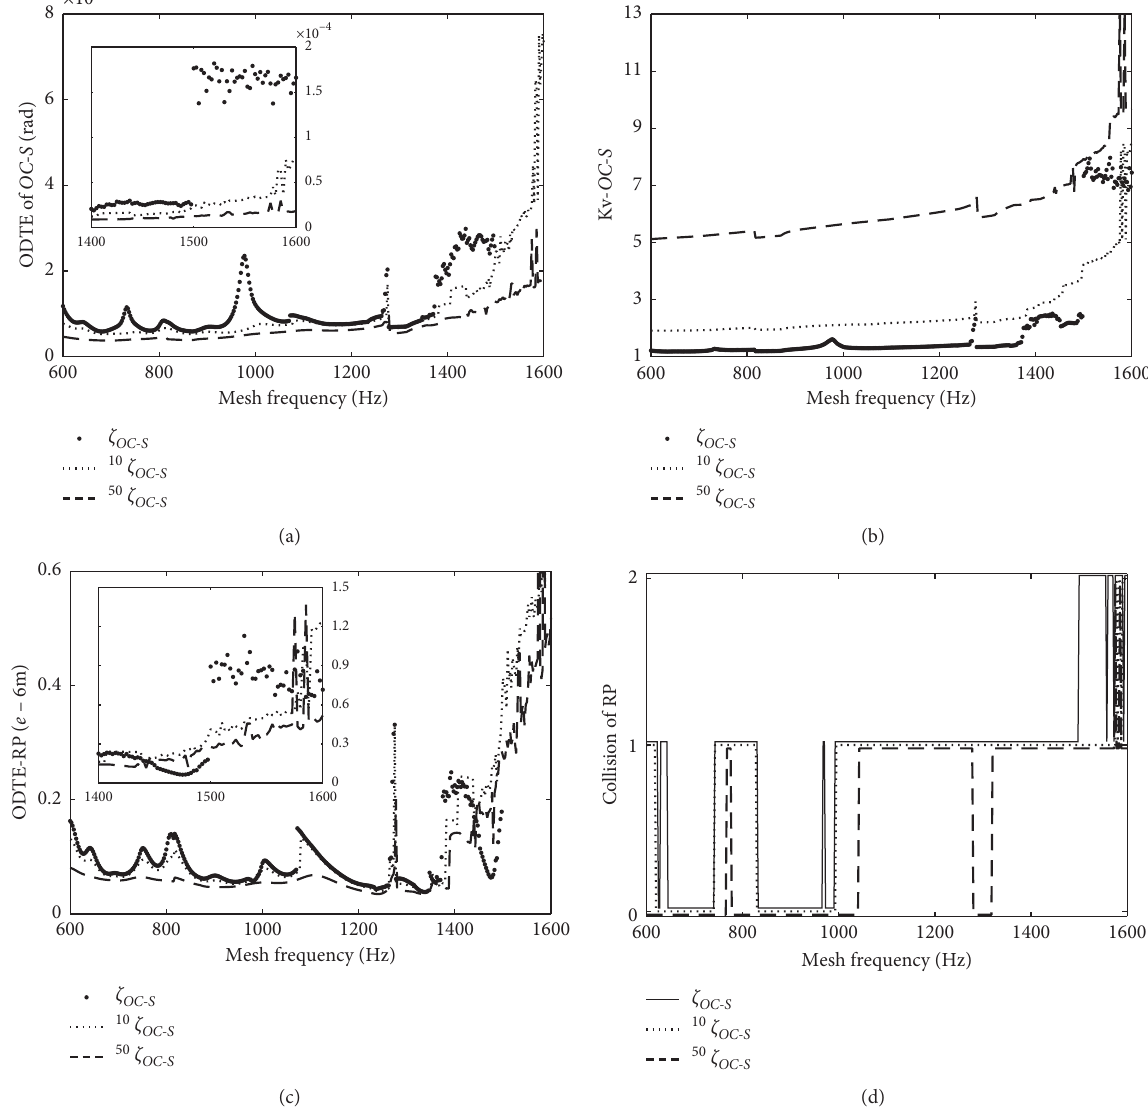
Figure 12: Nonlinear dynamics of the unit as damping ratio of SOWC-S changed. (a) Vibration characteristics of SOWC-S. (b) Load characteristics of SOWC-S. (c) Vibration characteristics of RP. (d) Collision of